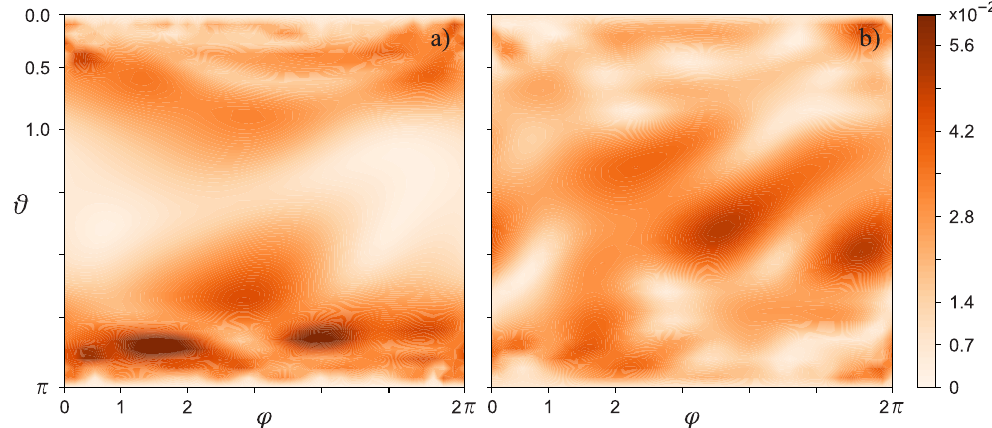
Figure 5. The normalized value of the magnitude of the retrieved magnetic mass carrier density M ( ρ cos ϕ sin θ , ρ sin ϕ sin θ , ρ cos θ ) . The calculations were carried out for data localized in the spher-